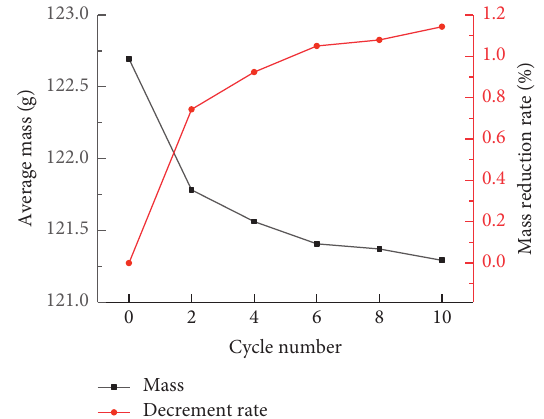
Figure 6: The relationship between specimen density and the number of cycles at high temperature.